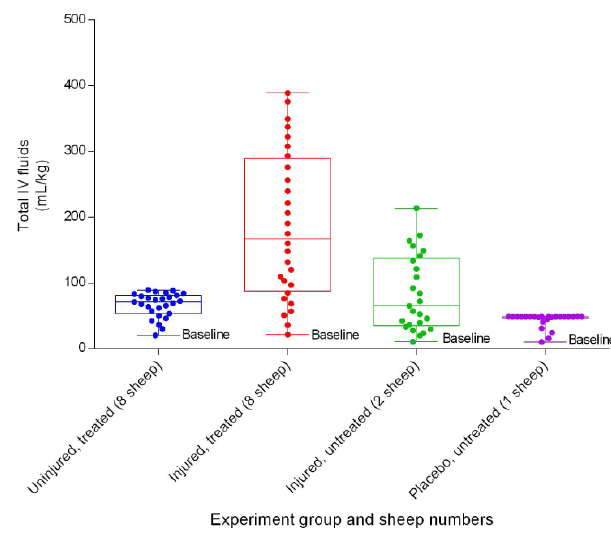
Figure 39. Total running intravenous fluids per unit body weight (Mean ± SD) in smoke and non-smoke injured sheep that received extracorporeal life support as compared to those in untreated controls over a 24h period.